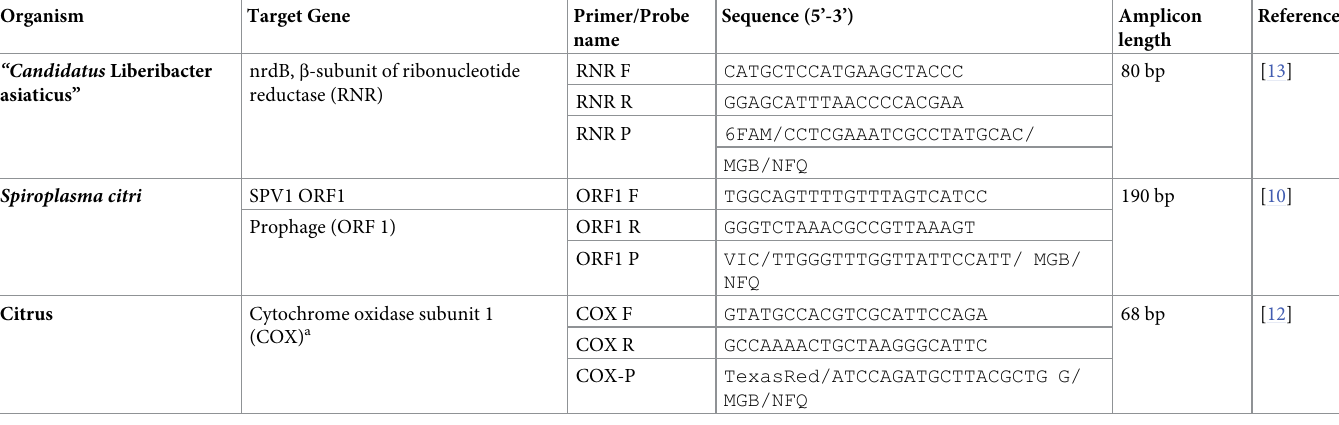
Table 1. Primer and probe sequences used for detection of “ Candidatus Liberibacter asiaticus” and Spiroplasma citri .